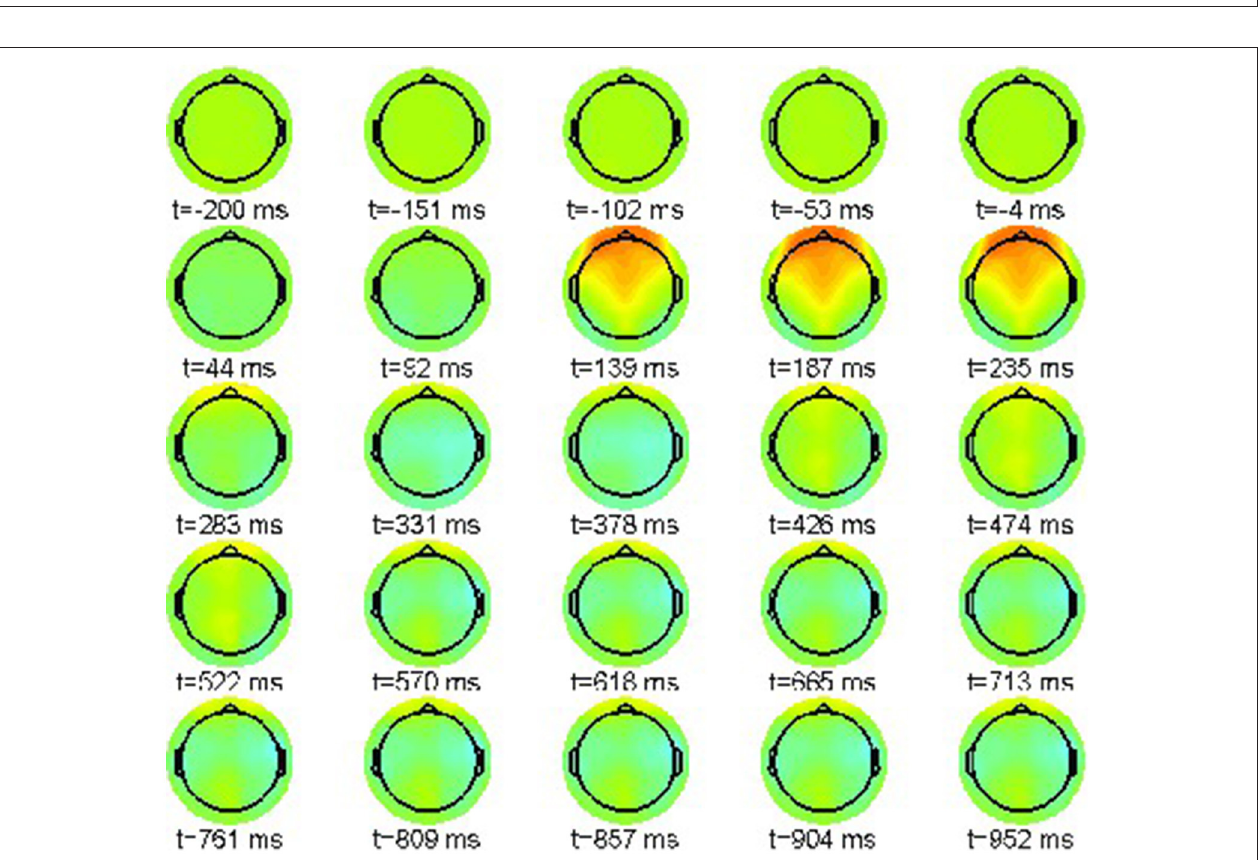
FIGURE 7 | Snapshot sequence of neural field scalp topographies for correct condition (22-a).